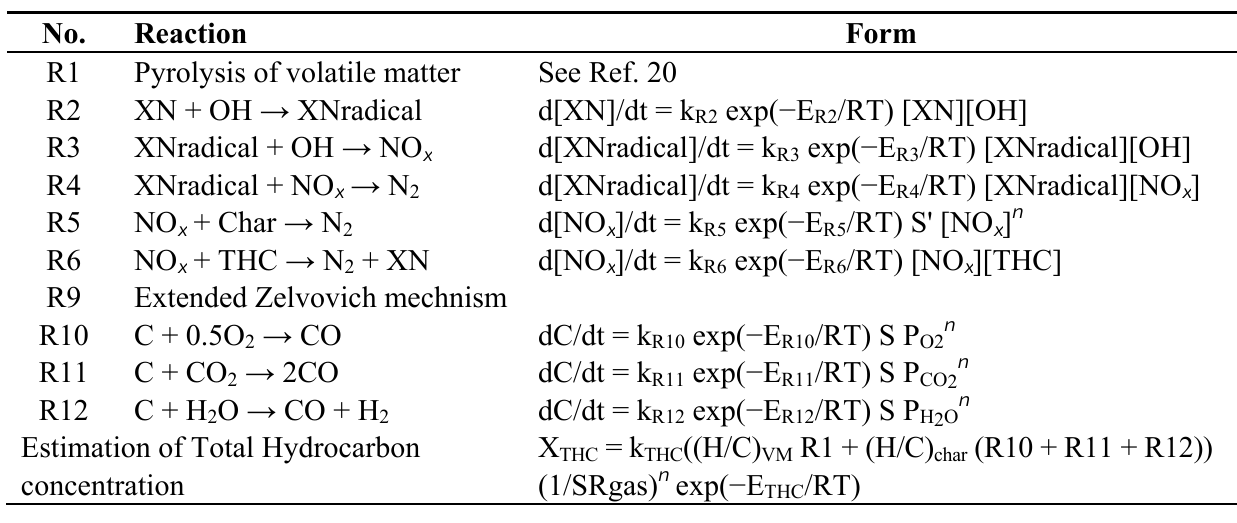
Table 1. Reactions used in this